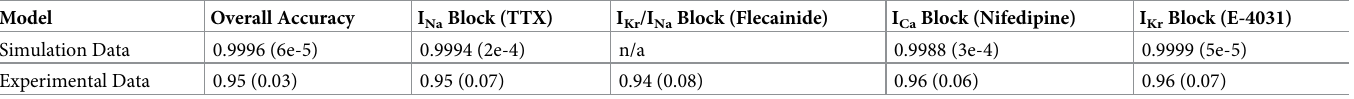
Table 4. Accuracy of detecting ion channel blocks from AP shape changes from computer simulation data using multi-class logistic regression. Results are reported as mean (standard deviation). Standard deviations were obtained by repeating the model fitting, hyperparameter tuning, and testing process on different training/test data- set splits as described in